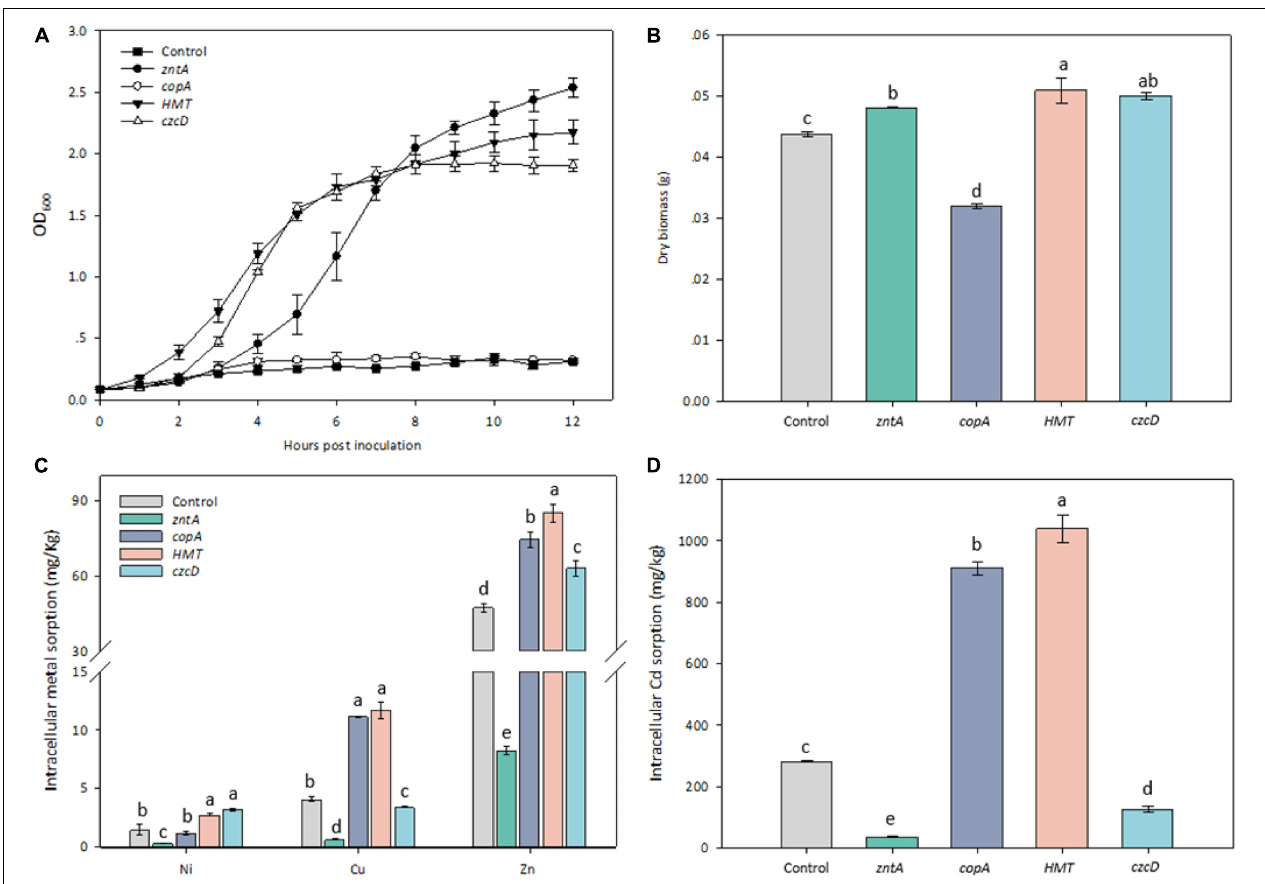
FIGURE 6 | Phenotypic response of Cd-sensitive strain harboring the tested metal resistance genes. (A) Growth curves of transformants harboring the tested resistance genes under 0.3 mM Cd; (B) dry biomass of transformants harboring the tested resistance genes; (C) cellular accumulation of Ni, Cu, and Zn by transformants harboring the tested resistance genes; (D) cellular accumulation of Cd by transformants harboring the tested resistance genes.